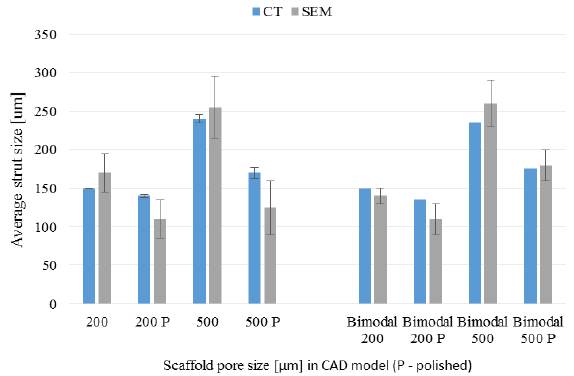
Figure 10. Scaffolds’ strut size before and after chemical polishing (P) measured by µ-CT/SEM methods.